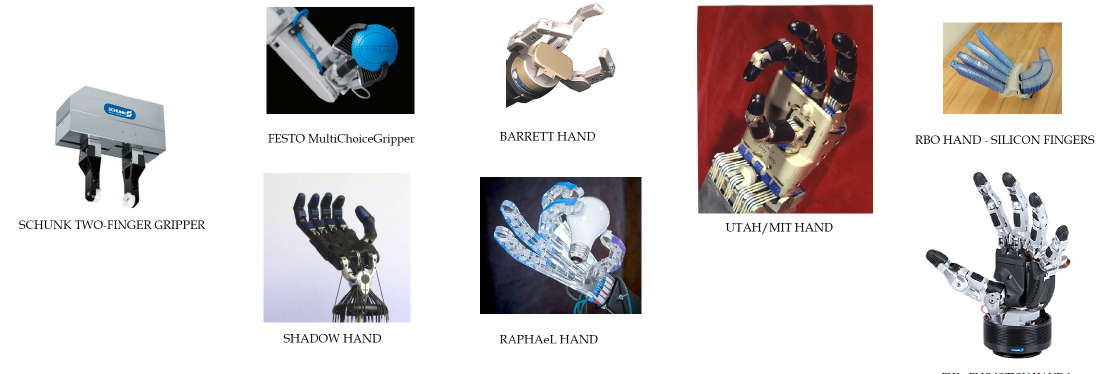
Figure 1. A sample of the evolution of robotic manipulators.